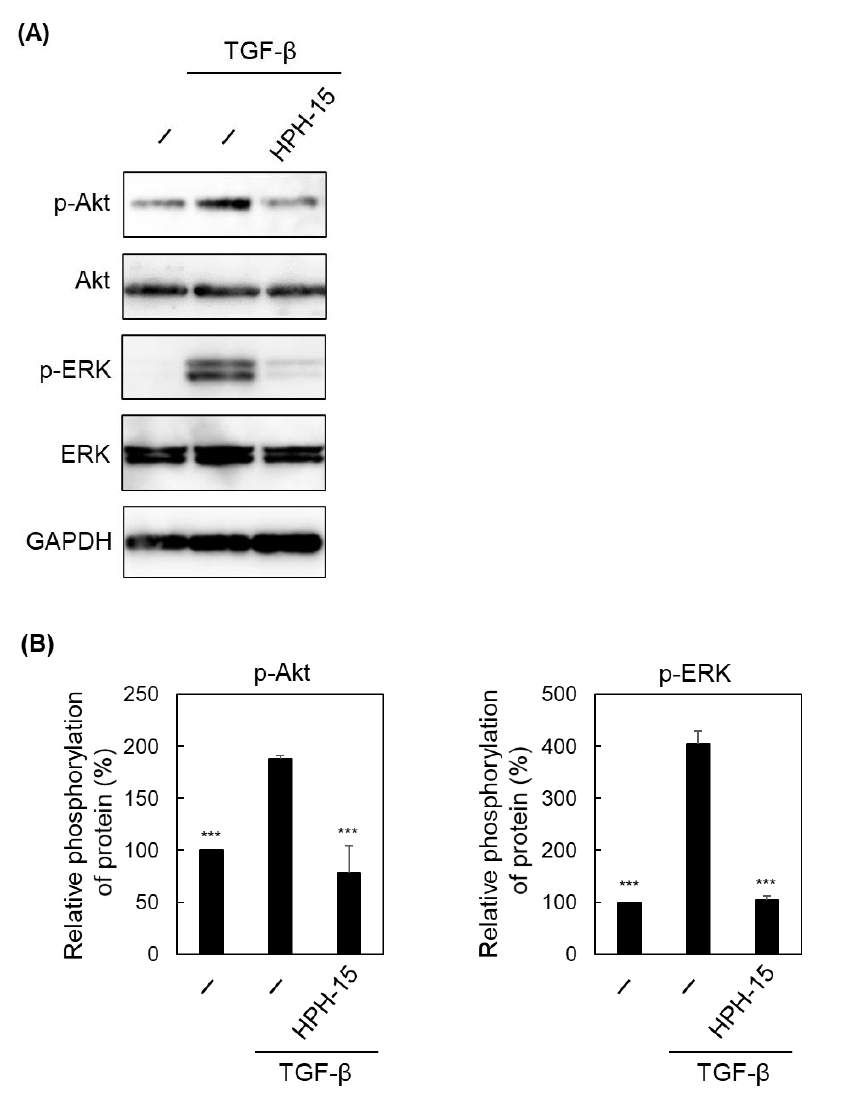
Figure 5. Effects of HPH-15 on a Smad-independent pathway in TGF- β signaling. ( A ) Protein levels of phosphorylated Akt and ERK in TGF- β -stimulated A549 cells treated with HPH-15. After incubating the cells for 1 d in the presence of HPH-15 (10 µ M) and TGF- β (10 ng/mL), the cells were lysed. The lysate was analyzed by immunoblotting. ( B ) Quantification of the phosphorylation levels of Akt and ERK. The intensity of the bands in ( A ) was quantified using ImageJ. Relative values (band intensity of phosphorylated protein and that of unphosphorylated protein) are shown as values of “Relative phosphorylation of protein.” *** p < 0.001 compared with samples treated with TGF- β and without HPH -15.